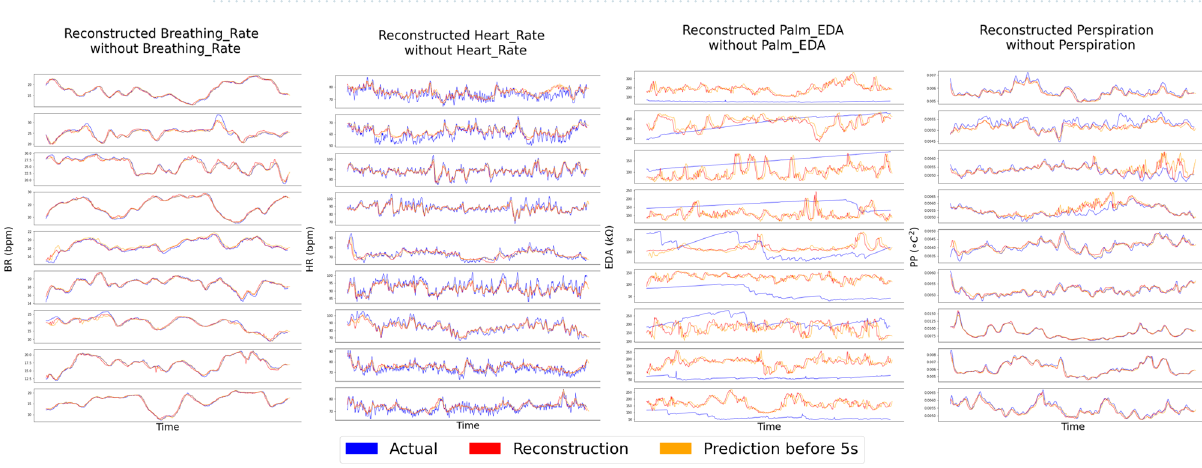
Figure 2. Reconstruction and future prediction made by our model for all nine testing sessions.